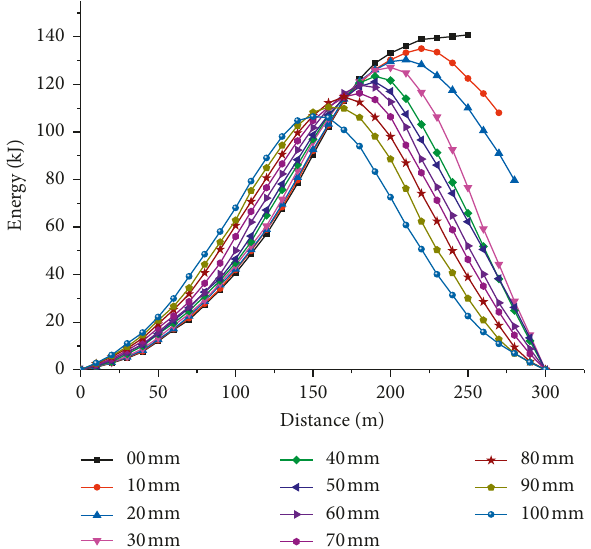
Figure 17: Changing curve of air energy with different vent diameters.